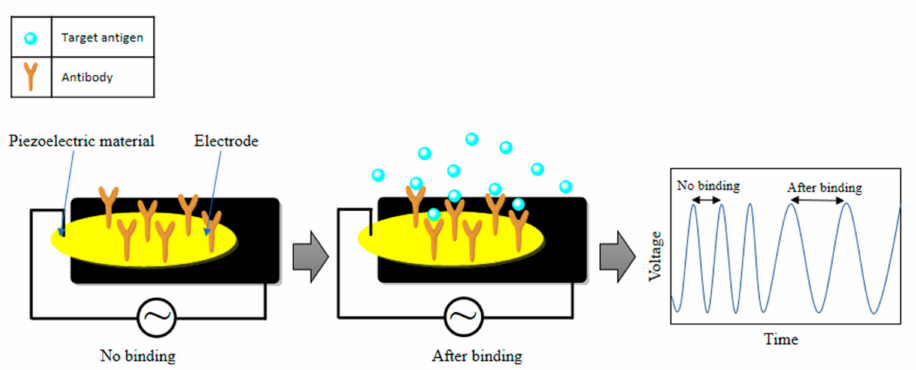
Figure 11. The operation principle of a piezoelectric biosensor.